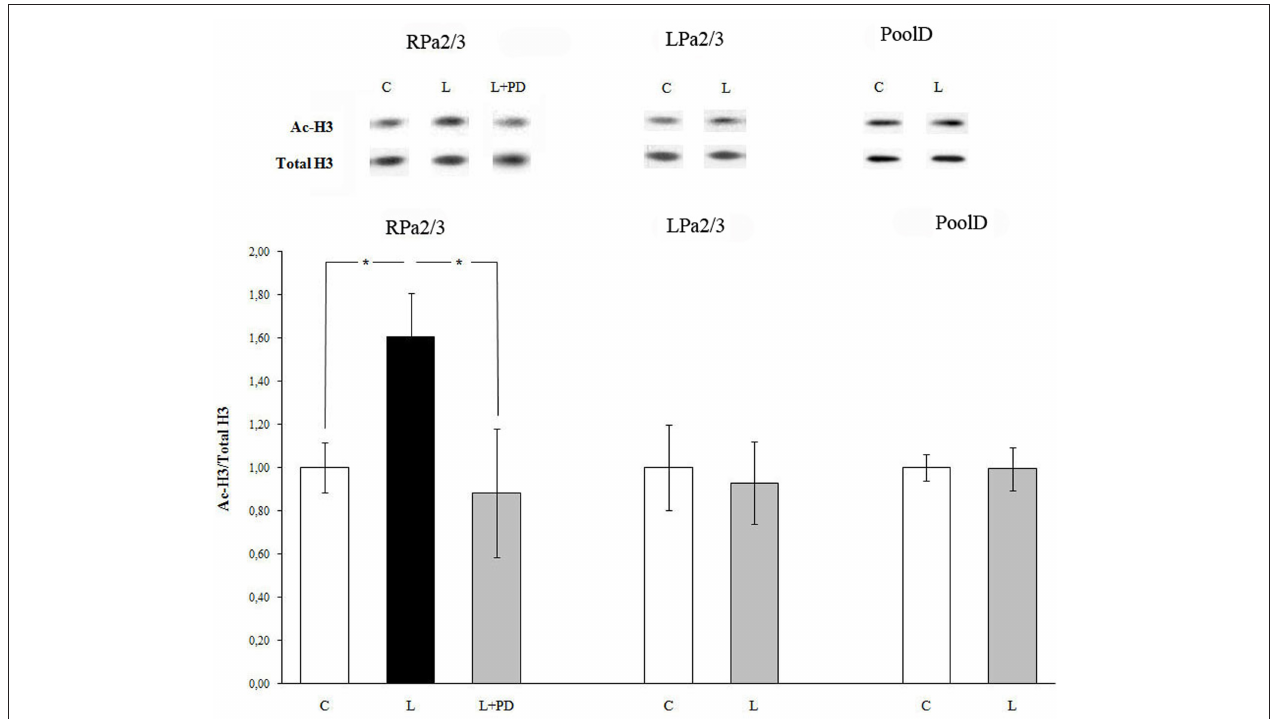
FiguRE 2 | Food aversion learning induces histone H3 acetylation in identified neurons of the CNS of Helix lucorum . Increased amount of H3 histone acetylation was detected 15 min after learning in command neurons of withdrawal behavior RPa(2/3) in comparison to naïve controls. The selective MEK inhibitor PD98059 abolished ERK activation. C, control naïve animals pretreated with the vehicle;